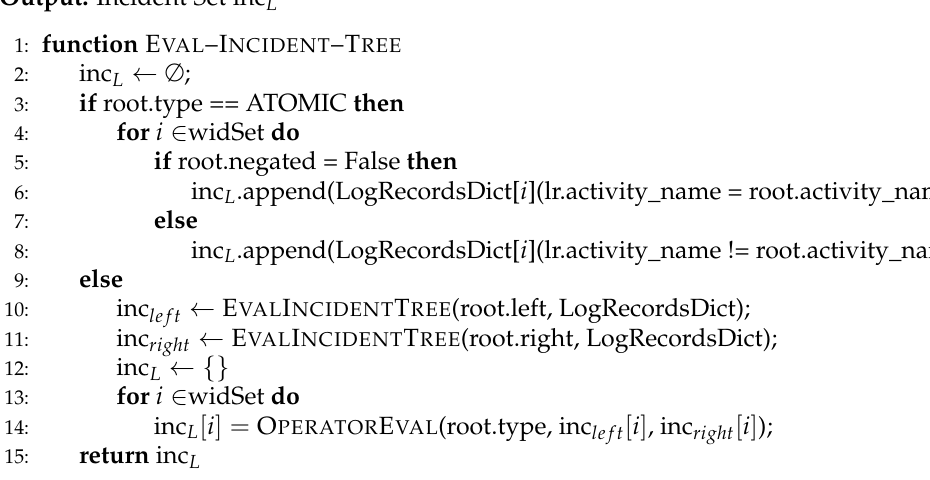
Algorithm 2 Incident tree evaluation